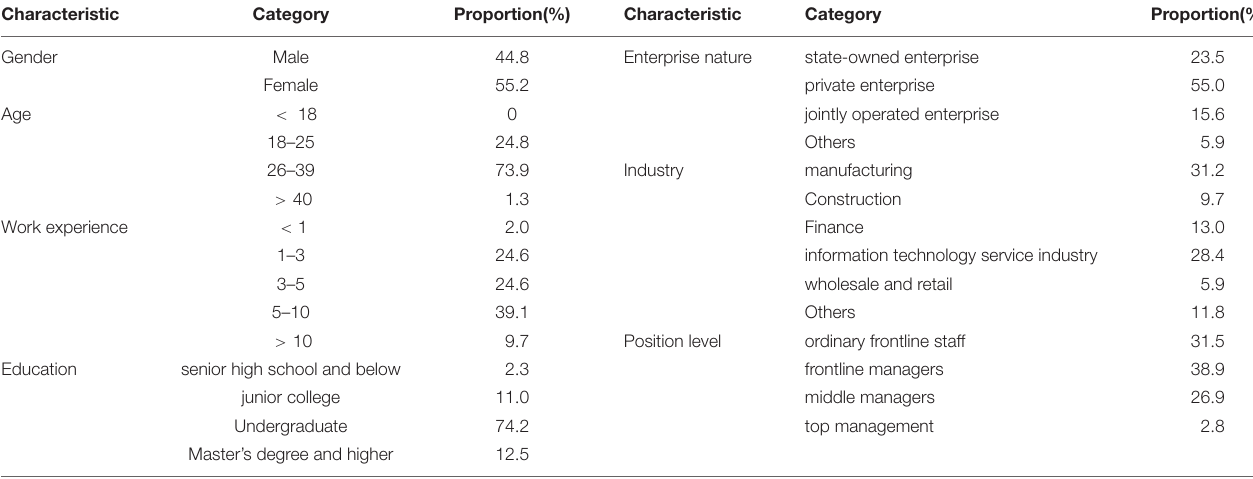
TABLE 1 | Distribution of demographic characteristics of samples.